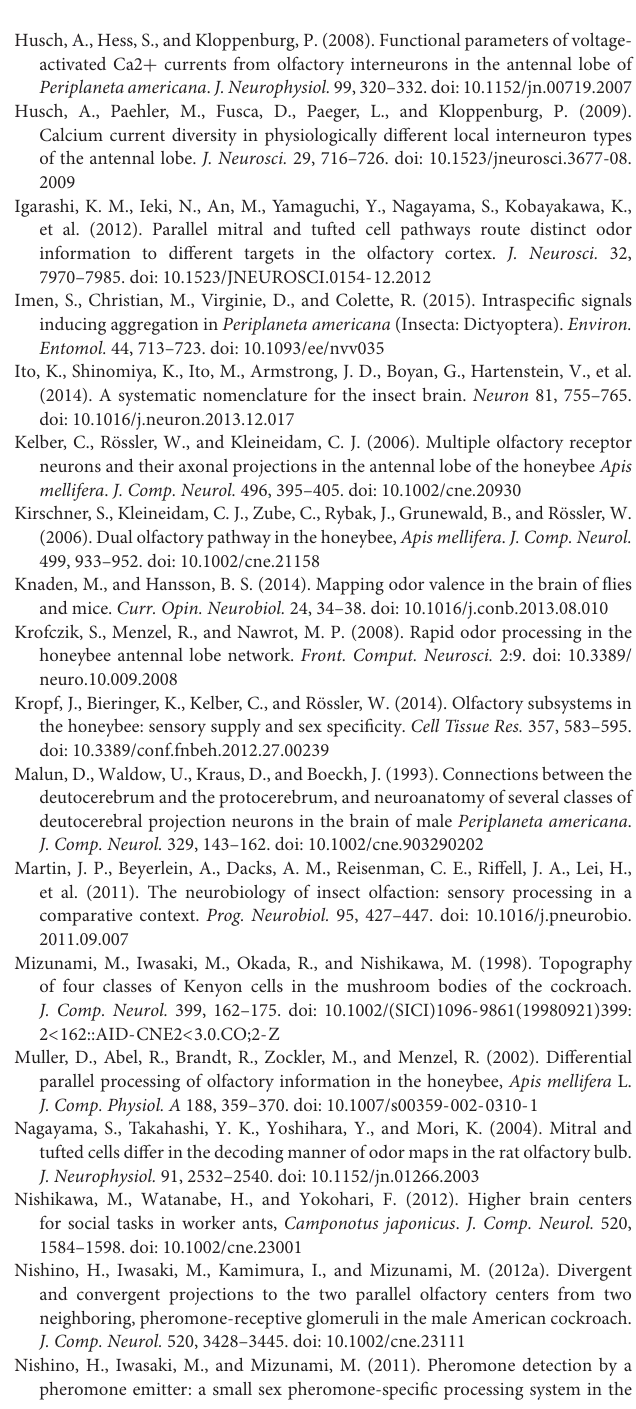
FIGURE S2 | Cluster analysis of temporal activity patterns elicited by hexanol. Based on peri-stimulus time histograms (PSTHs) during the 1-s hexanol stimulations, we classified 68 PN responses into four response clusters. The four response clusters are arbitrarily grouped based on the cluster dendrogram (left panel, height 30) formed by Ward’s method and PSTHs. The heat map shows PSTHs with a bin of 20 ms, and the heater color represents higher spike activities within the bin. Red and green circles represent the responses from type1 and type2 PNs, respectively.